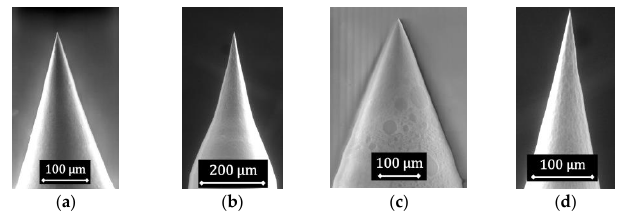
Figure 1. Example of scanning electron microscopy images of optical fiber nanotips: ( a ) linear profile obtained by means of slow rotation regime; ( b ) curved profile obtained by means of fast rotation regime; ( c ) cone angle of 50° obtained by means of slow rotation regime; ( d ) cone angle of about 2° obtained by means of fast rotation regime.